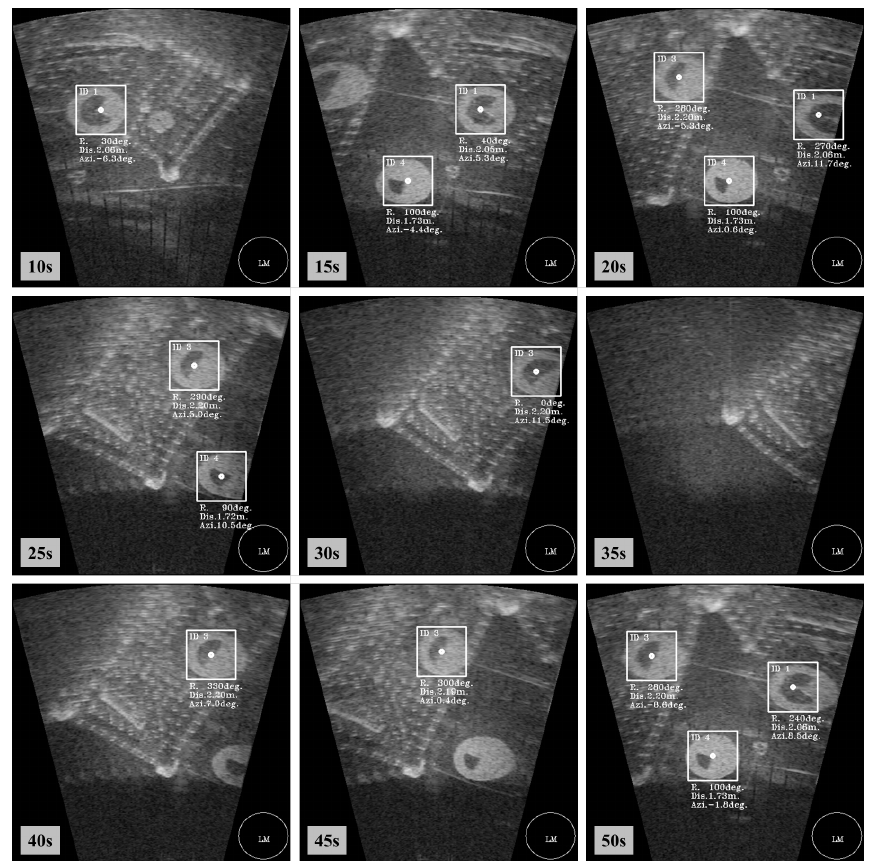
Figure 13. Experimental results of the proposed recognition framework